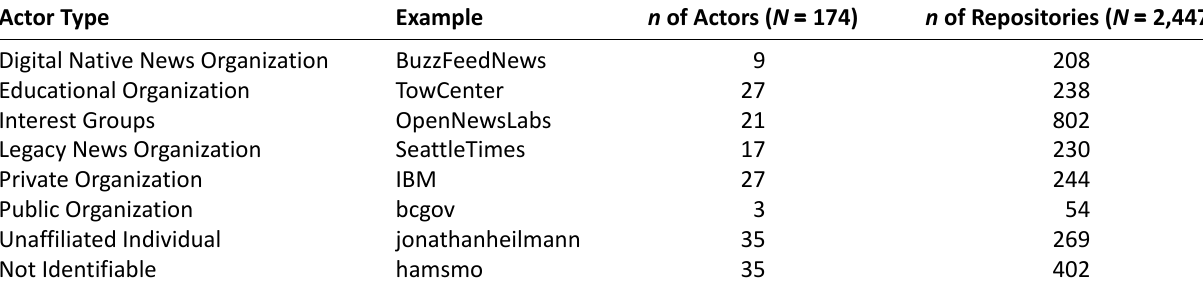
Table 1. Actors on GitHub based on an analysis of a subset of news-related accounts and repositories. Actor